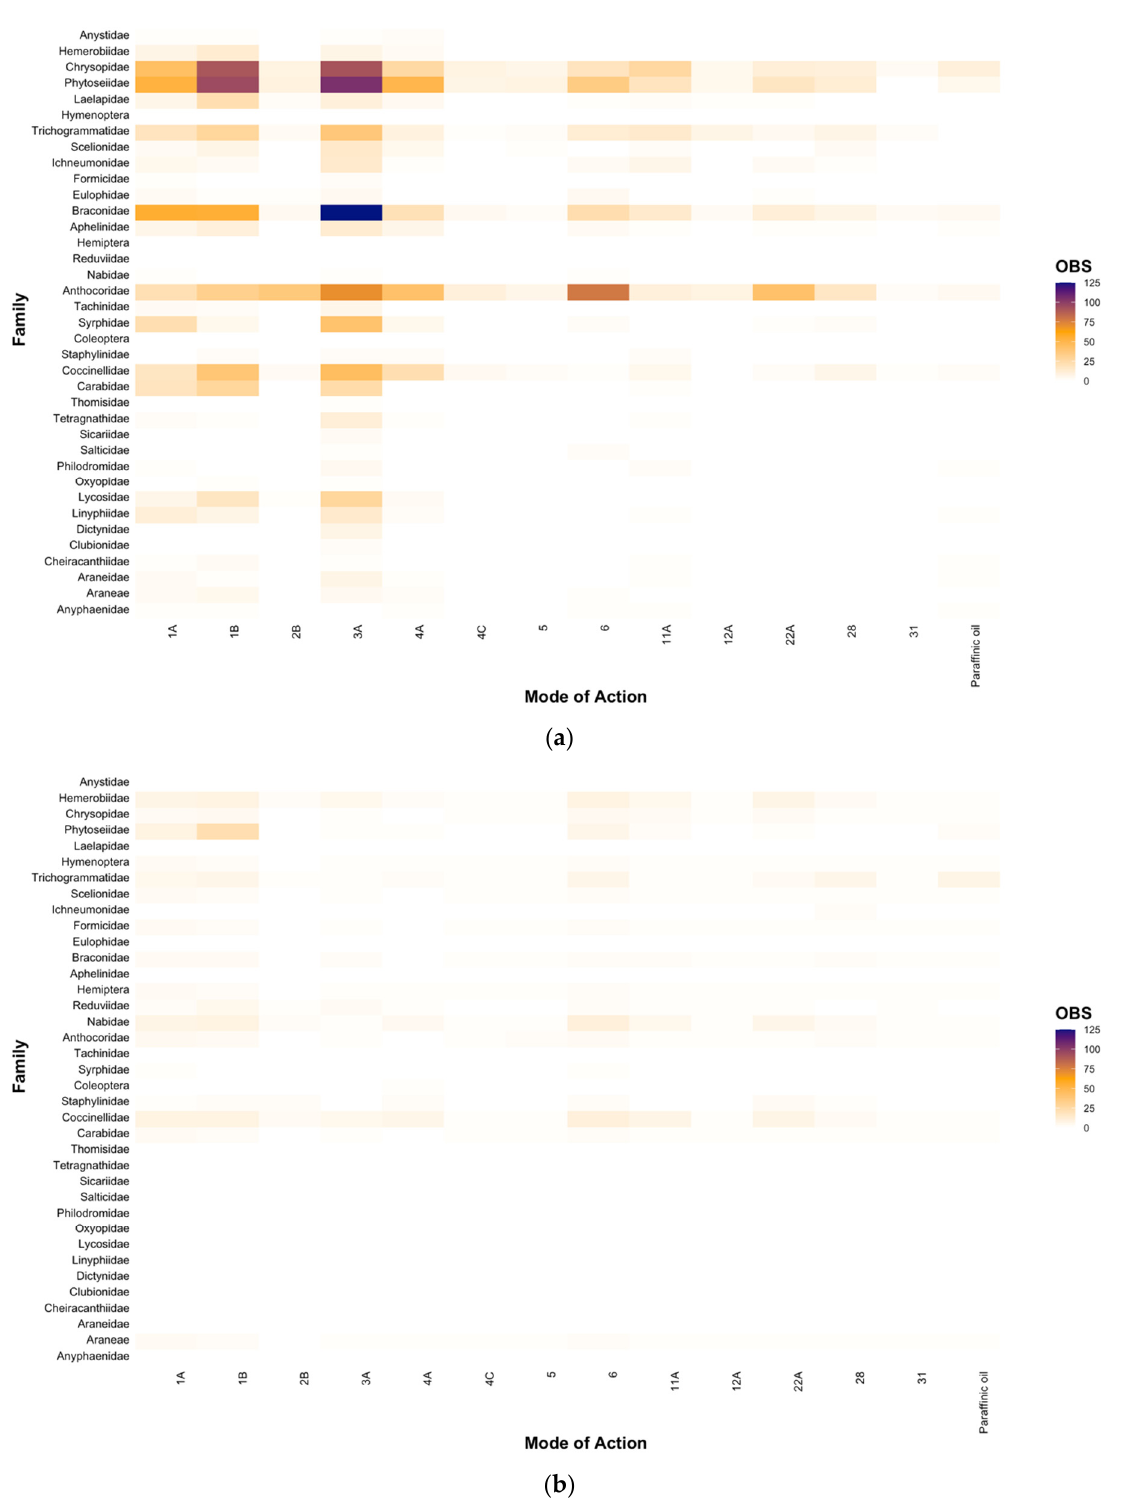
Figure 3. The number of entries (OBS) that tested the toxicity of chemical Modes of Action for each natural enemy family from studies conducted ( a ) internationally and ( b ) in Australia. Note: Araneae and Coleoptera are included as they were the lowest taxonomic classification provided in some studies.